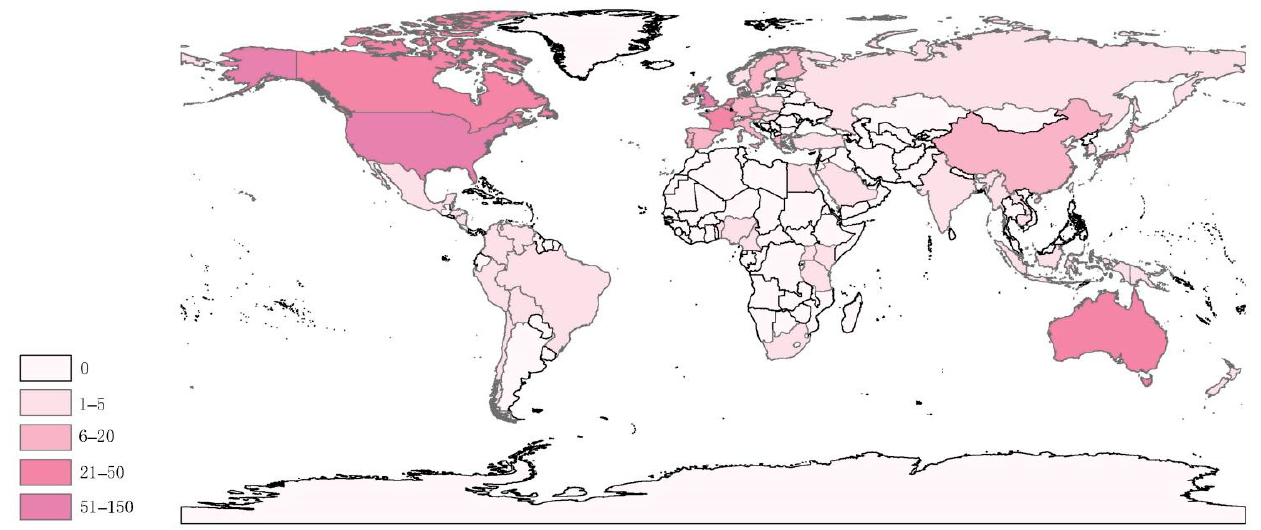
Figure 3. Global geographic distributions of publications during the period from 1990 to 2005.